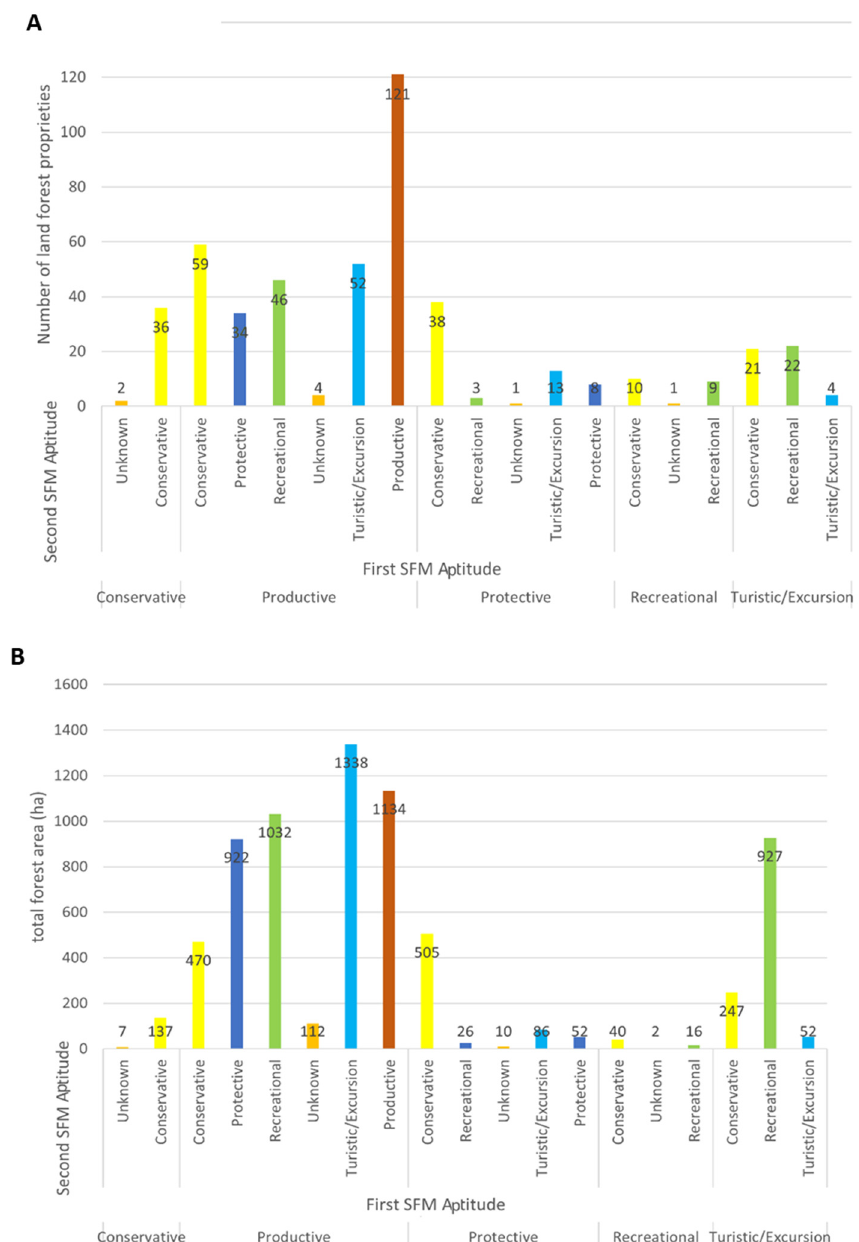
Figure 3. Panel ( A ). Number of forest properties per primary and secondary SFM attitude. Panel ( B ). Total forest area (ha) per primary and secondary SFM